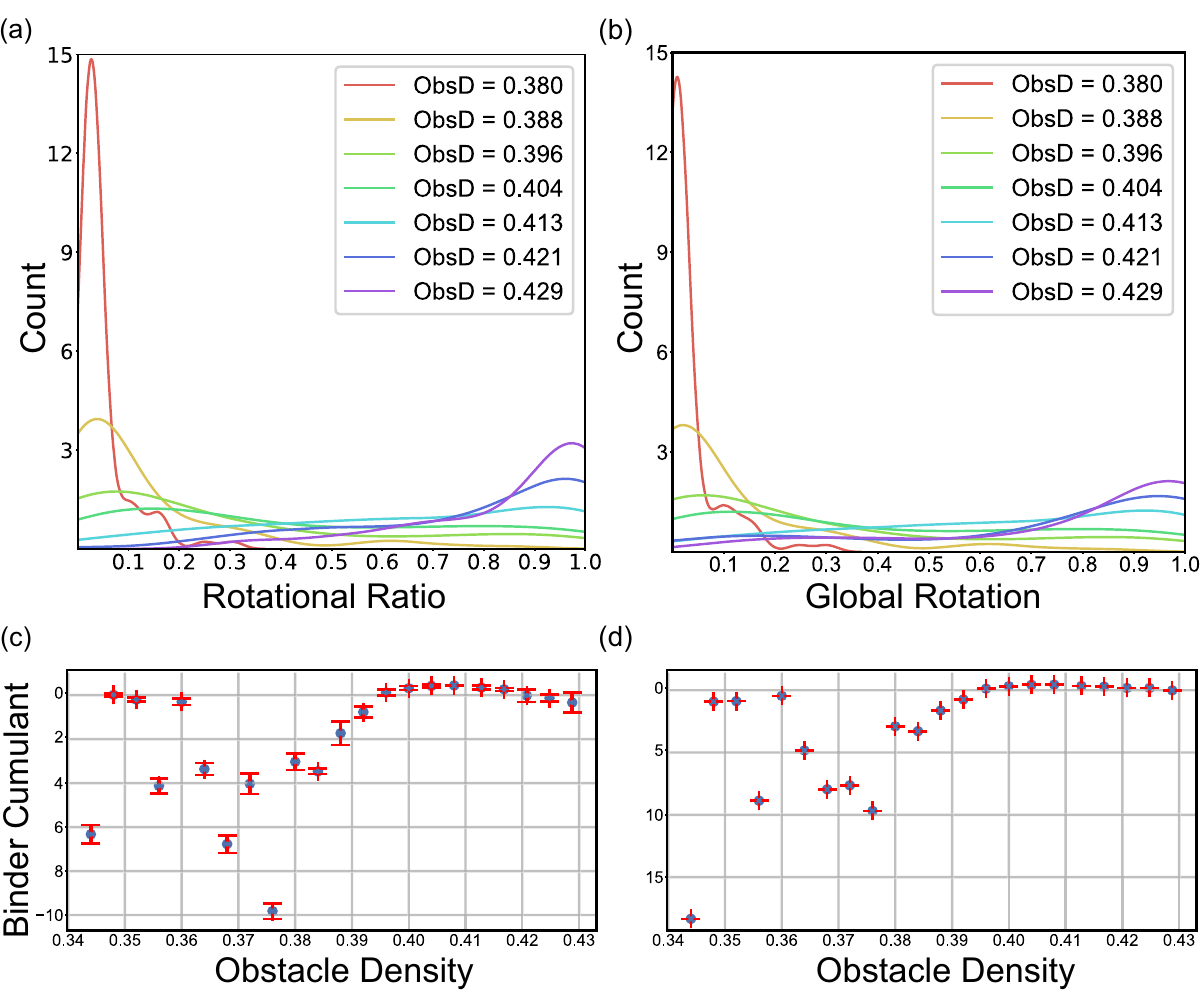
Fig. 7 Histograms and the Binder cumulant as a function of the obstacle densities. Panels a and b denote the histograms of order parameters over 90 runs in a 100 x 100 box with parameters the same as in Table 1. Panels c and d show the Binder cumulant of each set of those runs. To calculate the error bars, we divided the 90 runs into six groups of randomly selected runs. Calculated the average Binder cumulant of each group as its value and then calculated the error using standard error. For further explanation and interpretation of the above complex dependencies, see the “ Phase transitions and phase diagrams ”